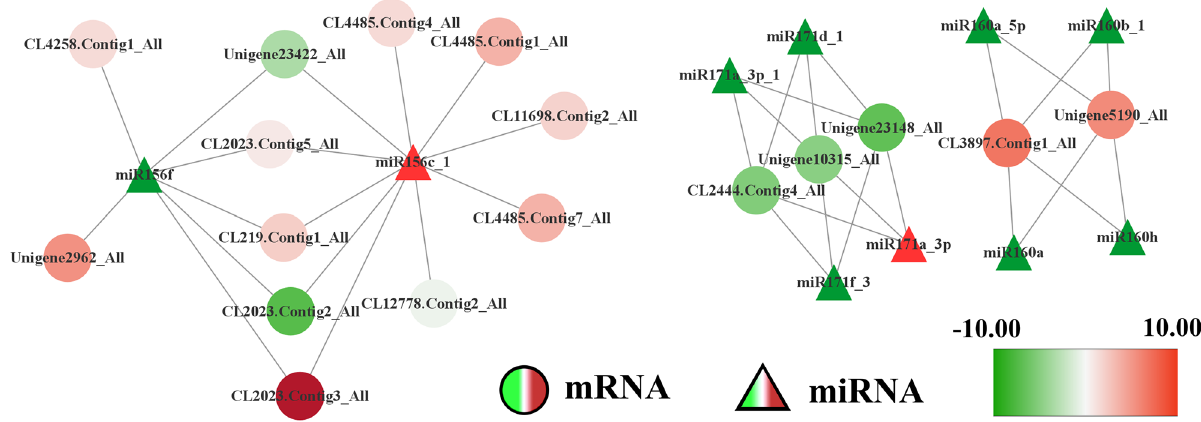
Figure 6. The miRNA-mRNA regulation networks of Ar-miR160a-5p , Ar-miR171d-1 and Ar-miR156f . Upregulated genes/miRNAs are shown in red; downregulated genes/miRNAs are shown in